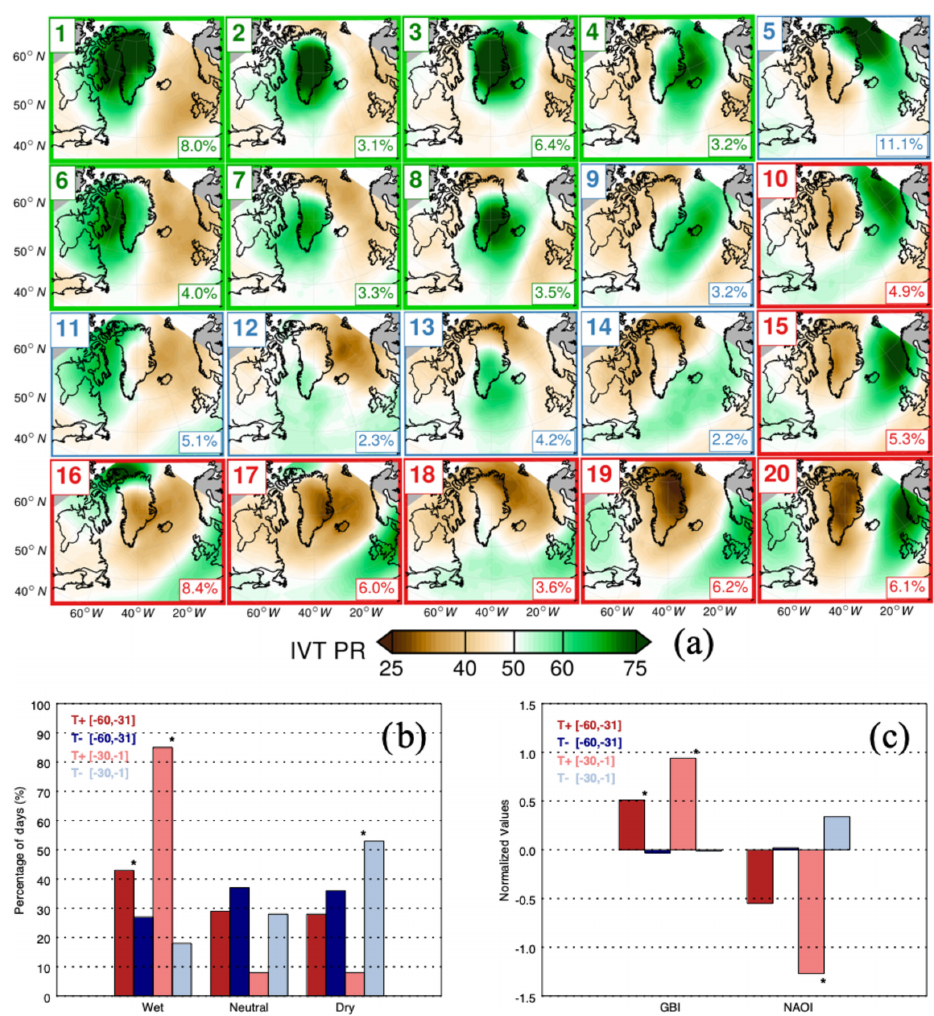
Figure 10. Percentile rank of integrated vapor transport fields (IVT PR) from ERA-Interim classified using a self-organizing map (SOM) approach (a) and composites of (b) IVT PR SOM node frequencies by wet, neutral, and dry types (%), which are outlined in green, blue, and red respectively in the above figure. SOM aggregates in panel (b) represent the ratio of each pattern’s occurrence to the sum of all patterns for each time period, and similarly colored bars sum to 100%. Composites presented in panel (c) represent normalized Greenland Blocking Index (GBI) and North Atlantic Oscillation (NAO) values (unitless) for T + and T − events at KAN_B for the two periods preceding the Baffin Bay date of sea ice advance (DOA). Significant differences ( p ≤ 0 . 05) between T + and T − composites over similar time windows are shown by an asterisk ( ∗ ) between the